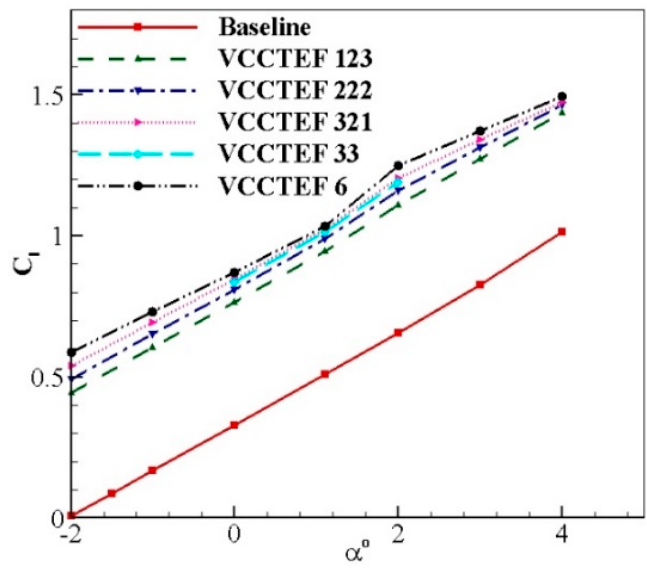
Figure 23. Variation of the computed coefficient of lift, C l with various angles of attack, α .